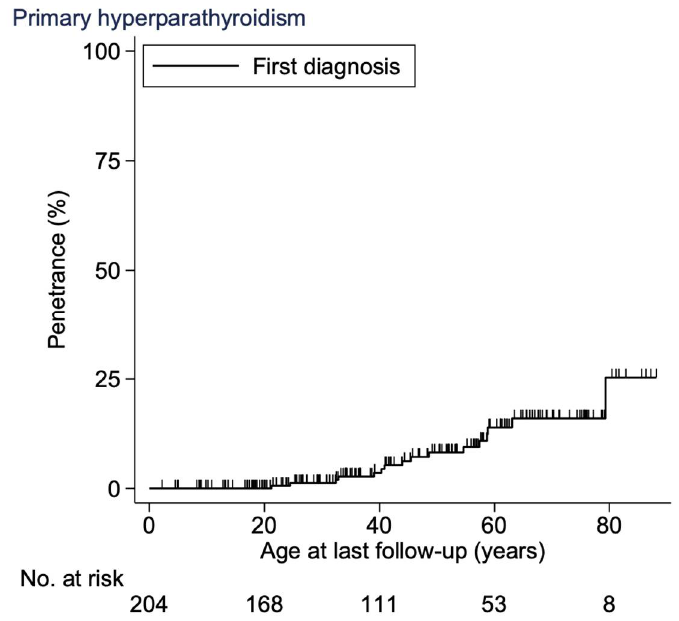
Figure 2. Age-related penetrance of PHPT in the Danish MEN 2A cohort 1930–2021. Abbreviations: PHPT, primary hyperparathyroidism; MEN 2A, multiple endocrine neoplasia type 2A.